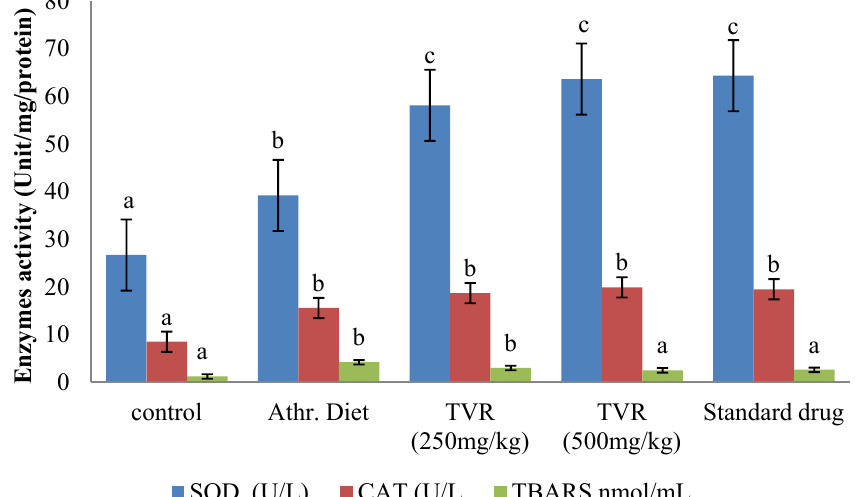
Figure 1. Effect of various doses of TVR on activity of tissue antioxidant enzymes in arota of diet-induced atherogenic rats. Mean values with the same letter subscripts within the different group are not significantly different ( p < 0.05).